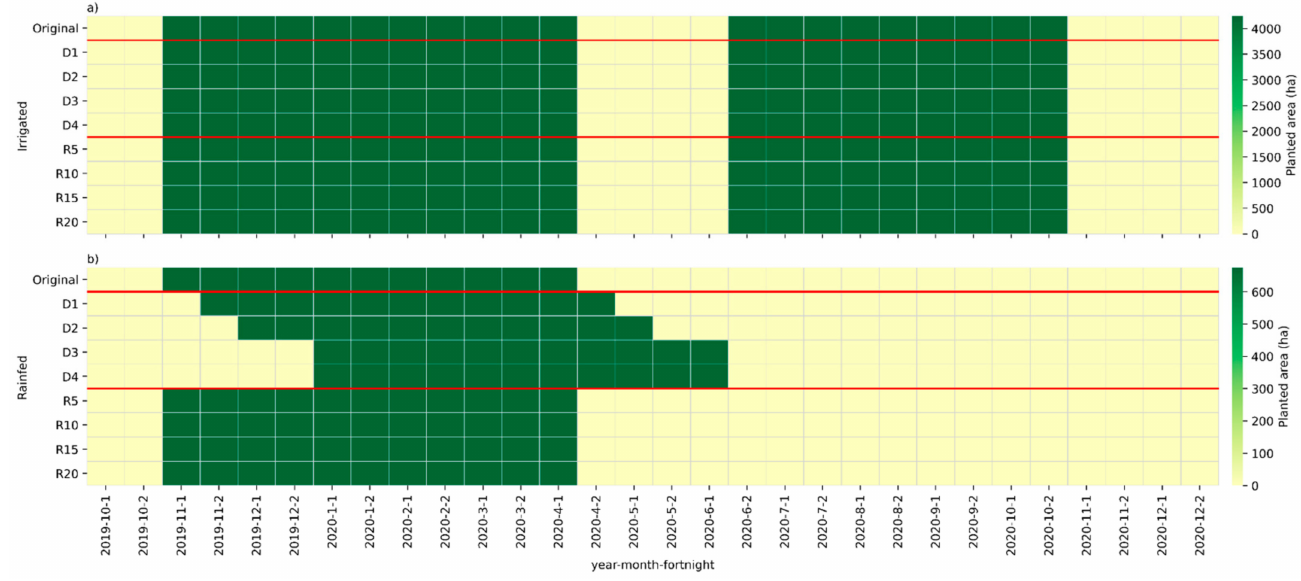
Figure 7. Planted area, in hectares, recommended by LPM application at Busato farm. ( a ) Shows the results for irrigated areas. ( b ) Shows the results for rainfed